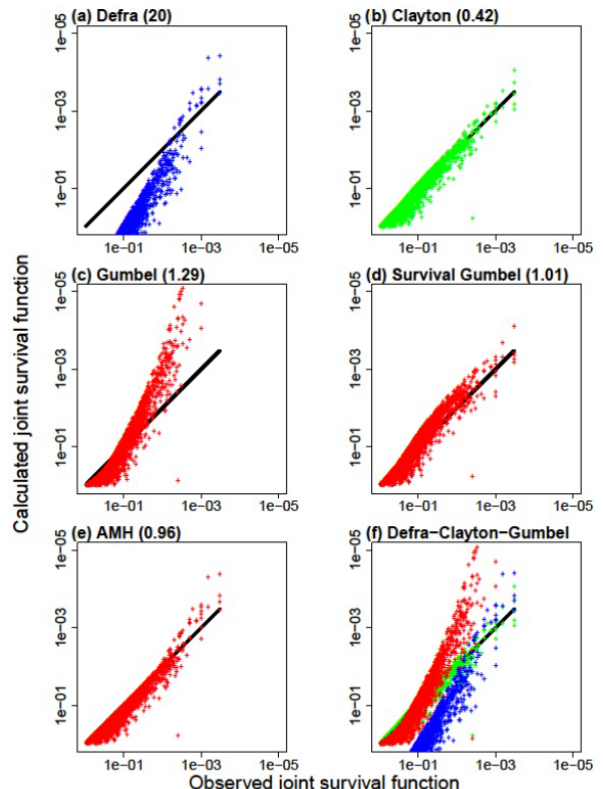
Figure 6. Comparison of the observed joint survival and the calcu- lated joint survival function for Le Havre with (a) the Defra method, (b) Clayton (0.42), (c) Gumbel (1.29), (d) Survival Gumbel (1.01), (e) AMH (0.96) and (f)